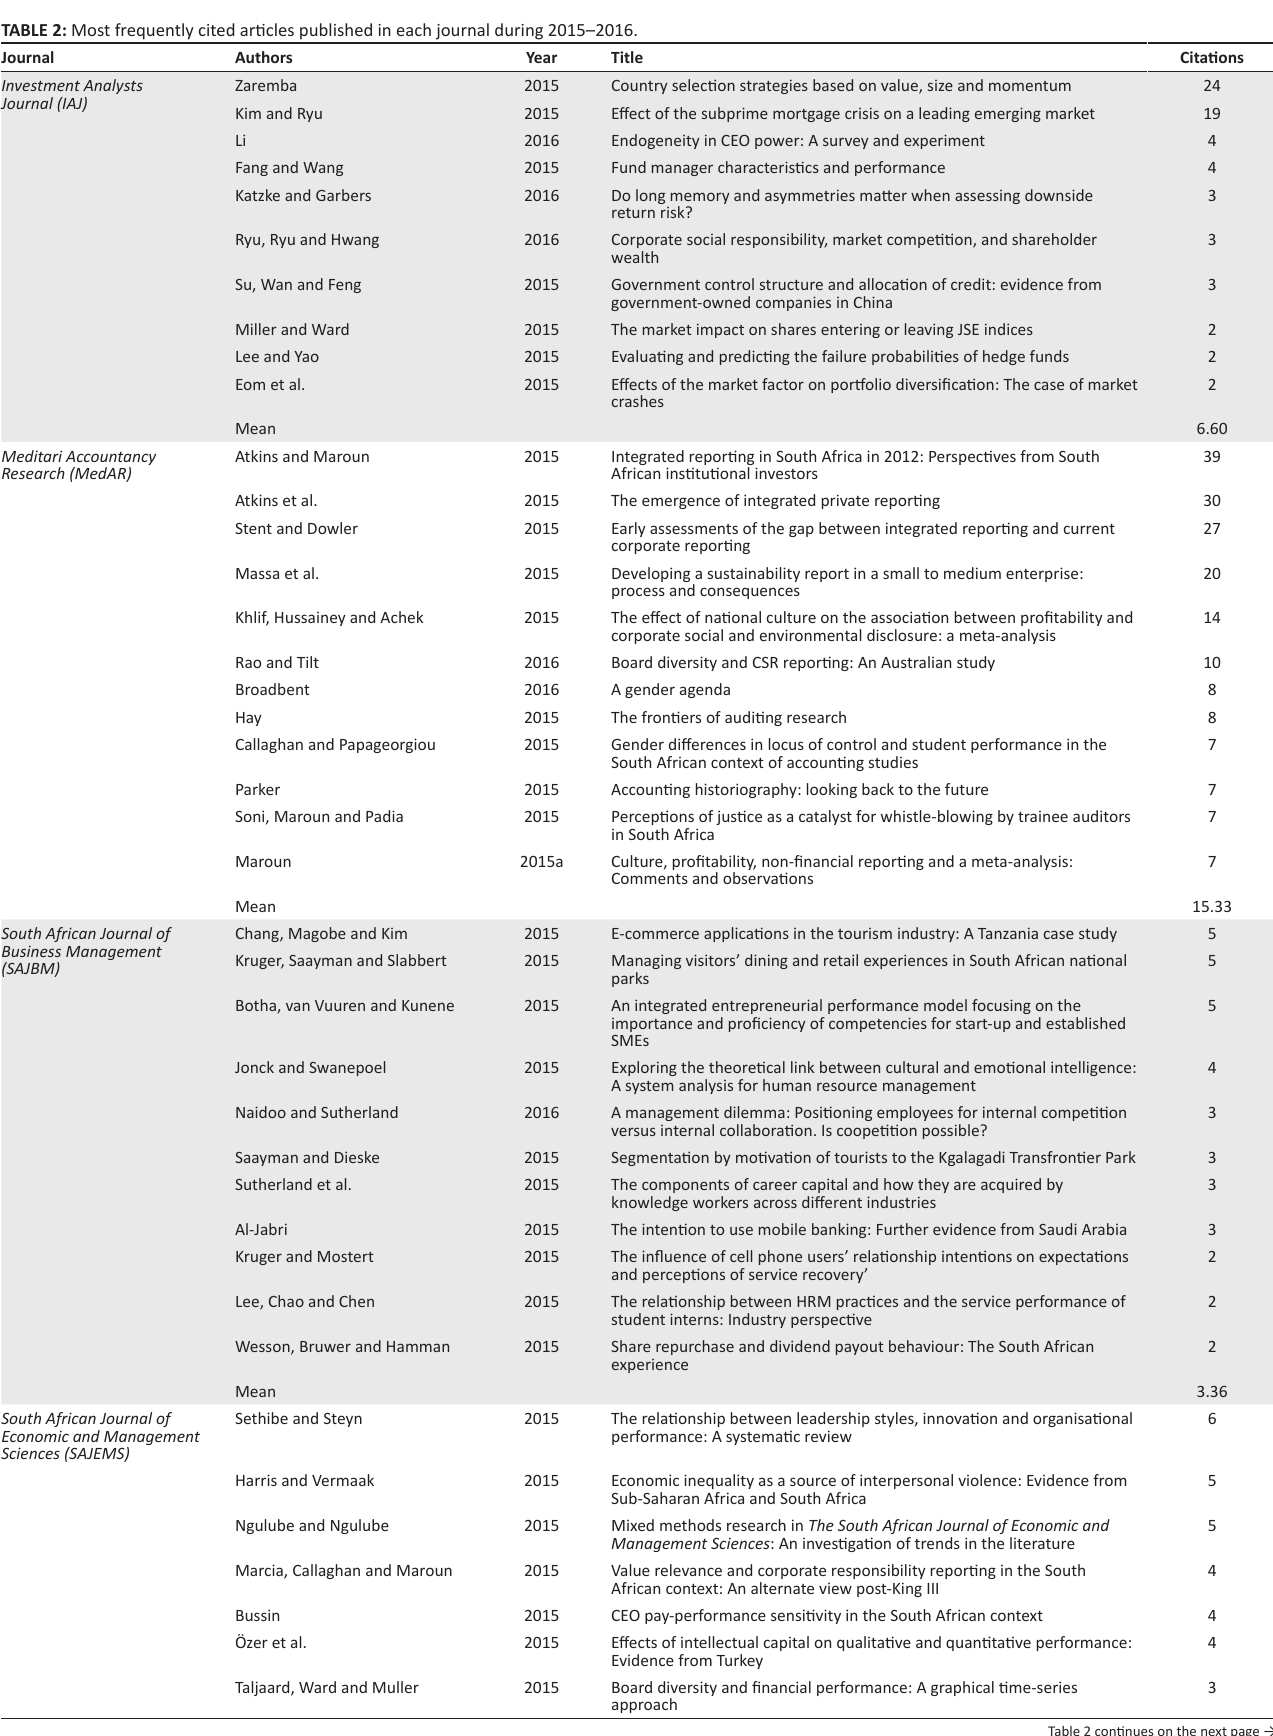
TABLE 2: Most frequently cited articles published in each journal during